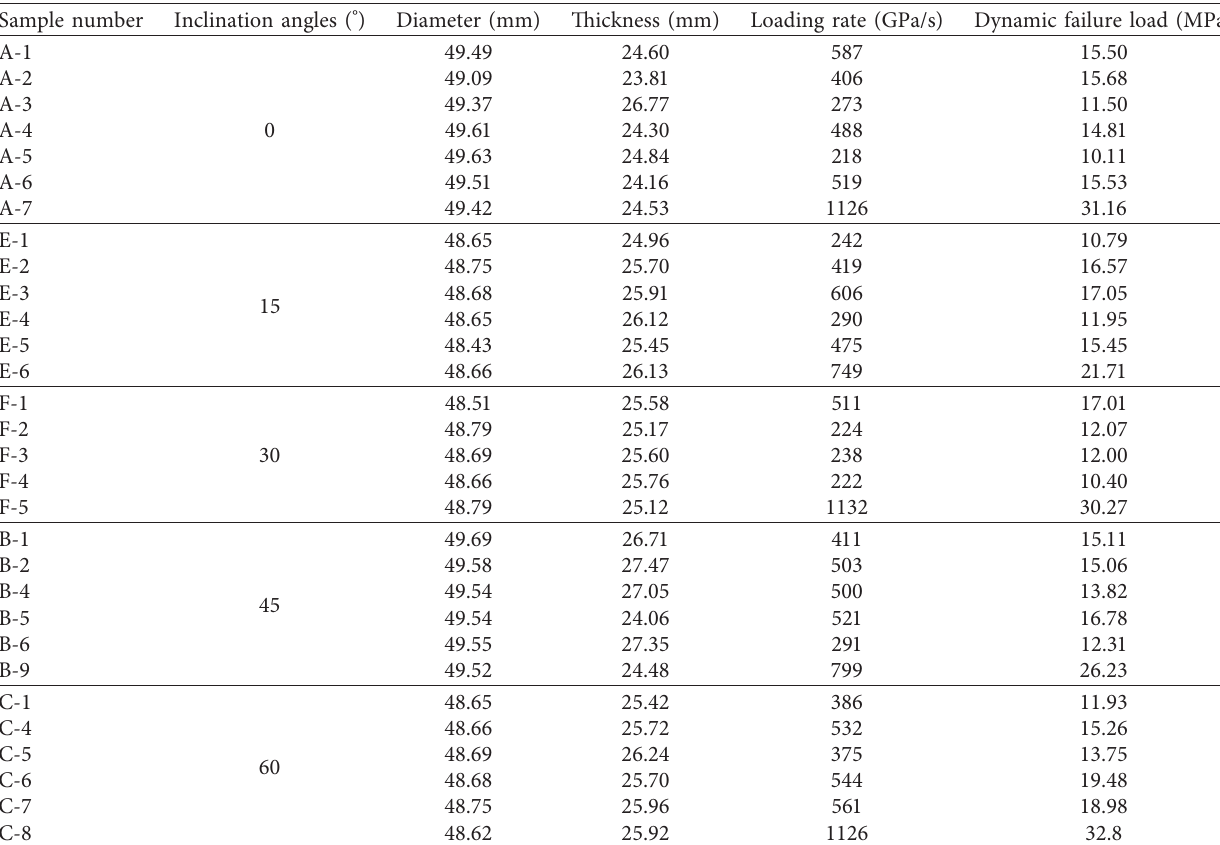
Table 3: Summary of the dynamic tensile test results on